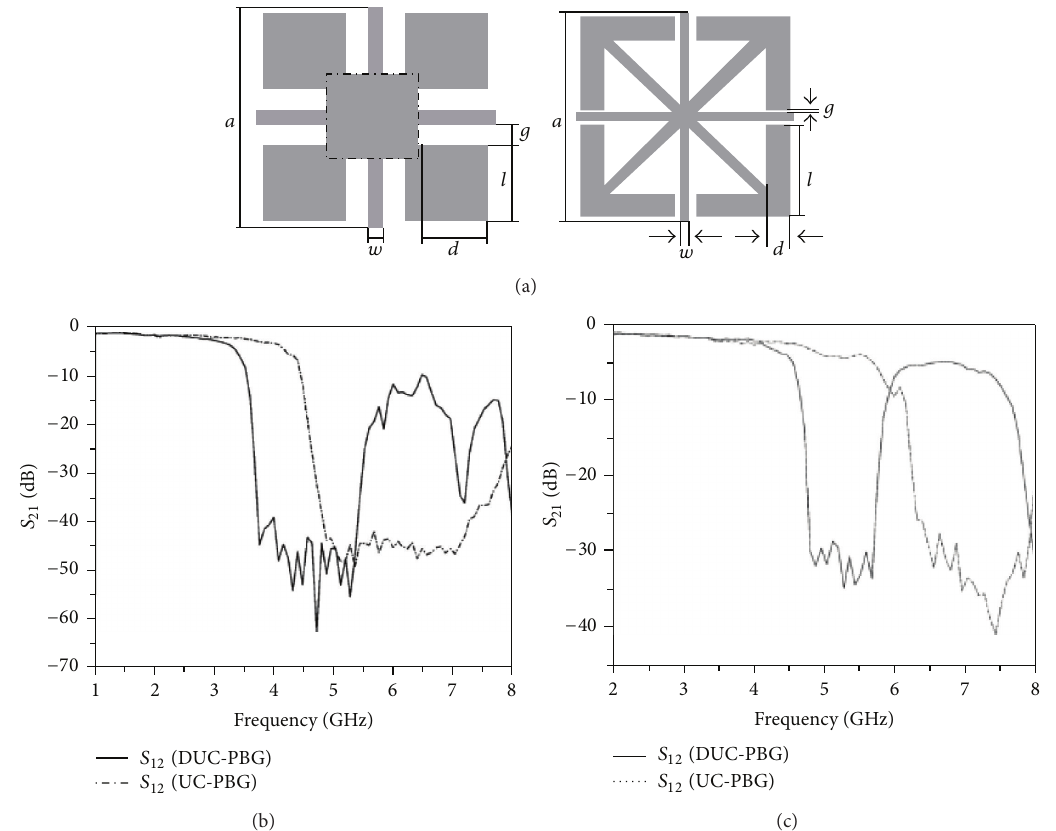
Figure 7: (a) A unit cell of the conventional UC-PBG and the proposed DUC-PBG. Transmission responses ( 𝑆 21 ) of the EBG structures: (b) microstrip line on same layer and (c) microstrip line on another layer.